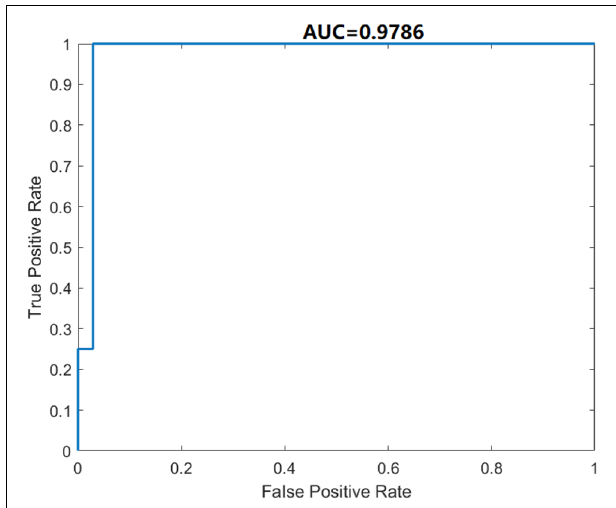
FIGURE 6 | ROC curve of DSNN.